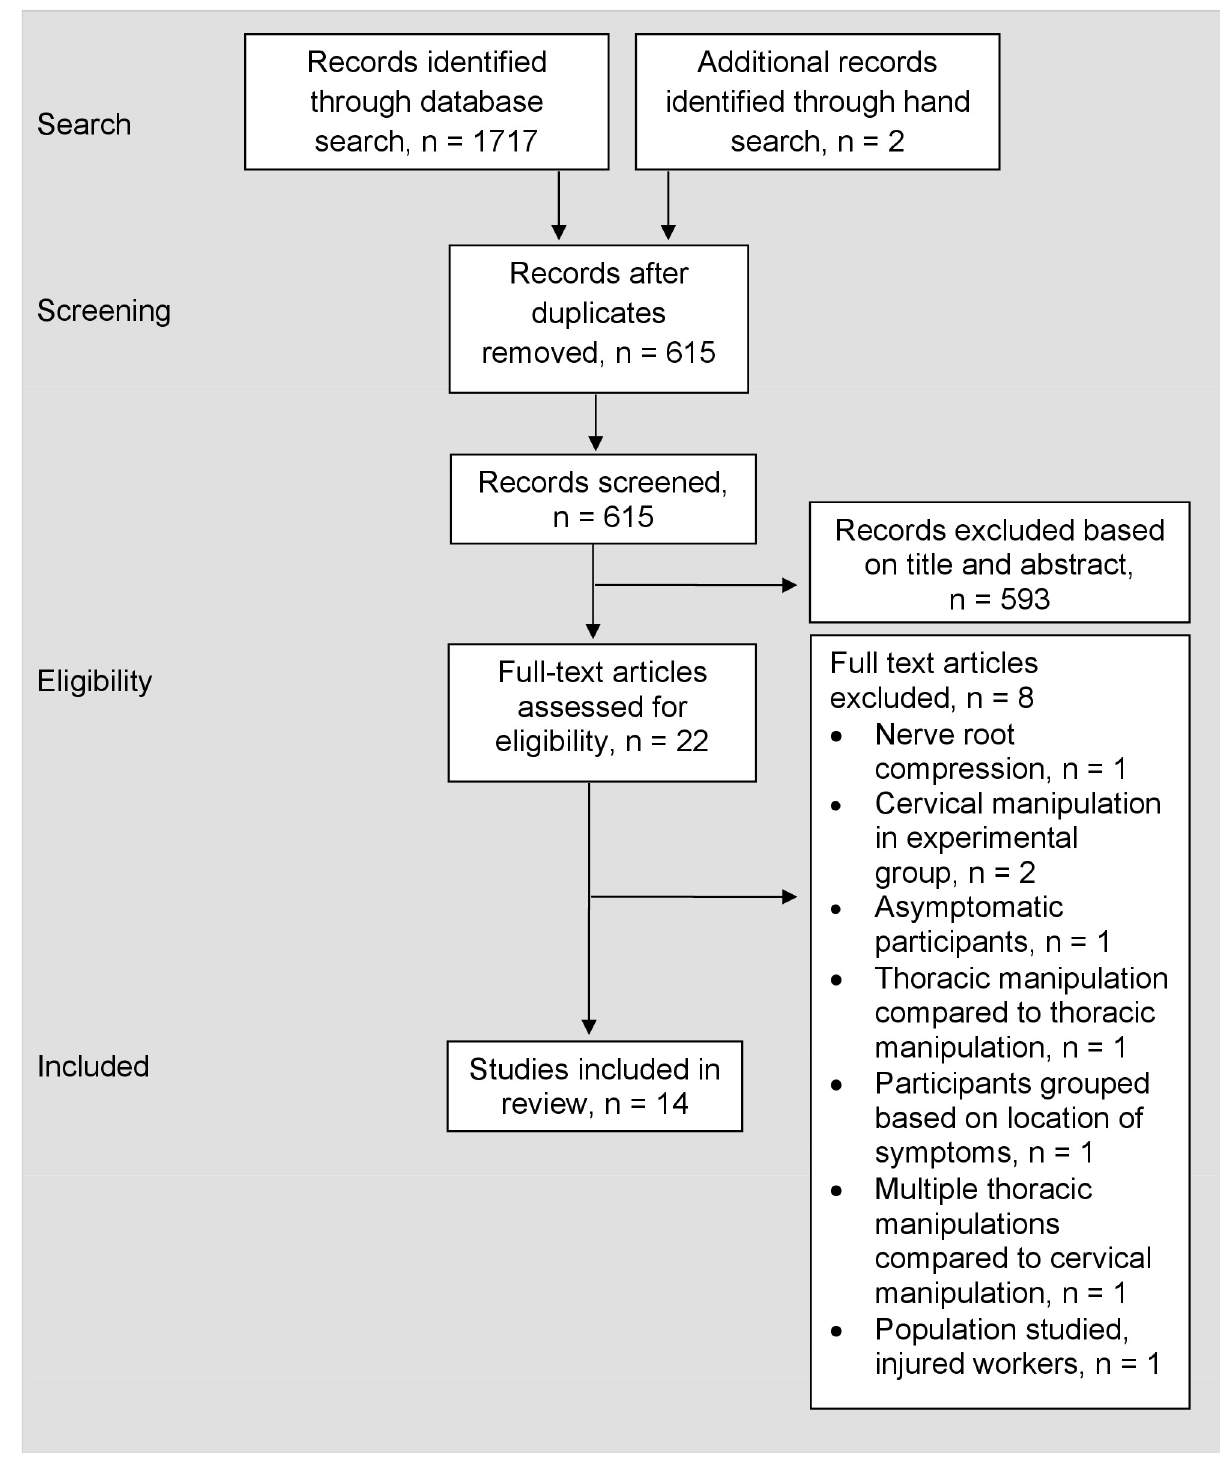
Fig 1. PRISMA flow diagram of search results and studies included.